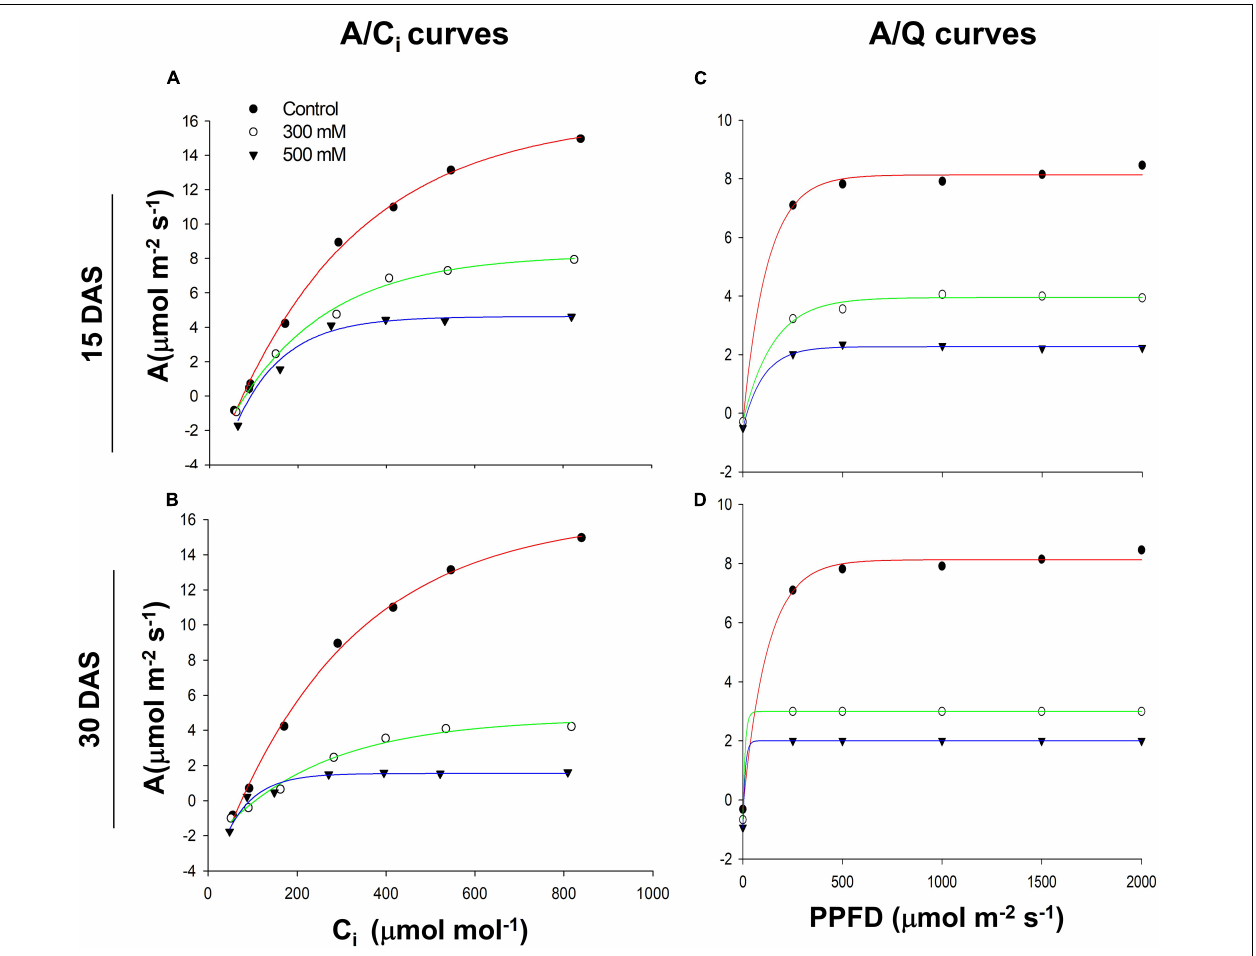
FIGURE 3 | Salt-induced response of photosynthetic rates to intercellular (CO 2 ) (C i ) (A) 15 days after salt treatment (DAS) and (B) 30 DAS. Photosynthetic rates to photosynthetic photon flux density (PPFD) (C) 15 and (D) 30 DAS in Pongamia grown under control and salt-treated conditions.